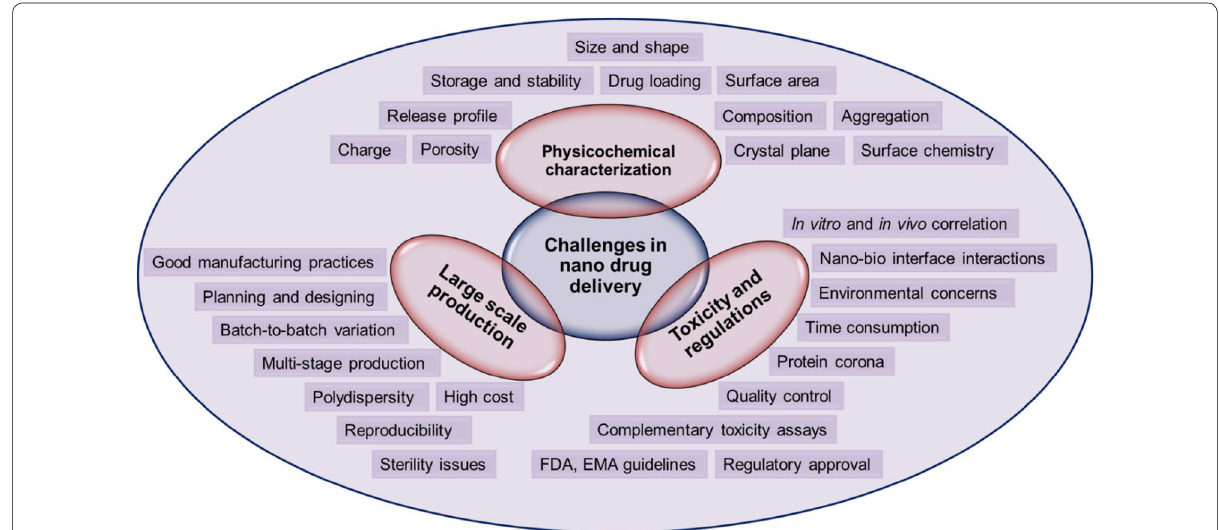
Fig. 9 Schematic illustration representing various challenges involved in the delivery of cancer